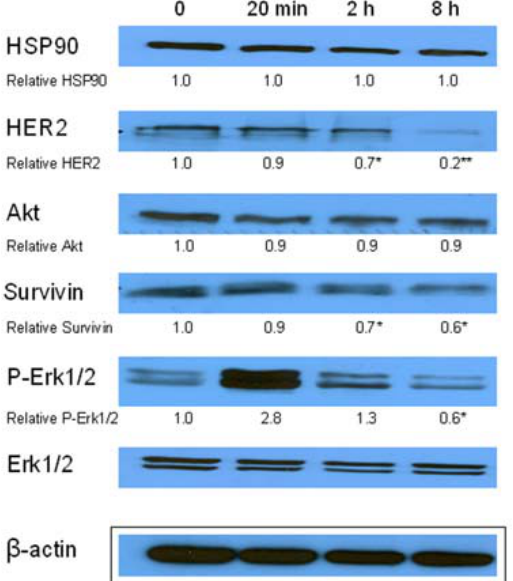
Figure 5. The effect of 17-DMAG treatment on HSP90, HER2, Akt, Survivin and P-Erk1/2 protein levels of SKBR-3 cells in different time after 17-DMAG. Total cell lysates were prepared 0, 20 min, 2 h or 8 h after 17-DMAG (19 nM) treatment. Equal loading was confirmed by detection of beta actin expression. The relative amounts (densitometric levels) of HSP90, HER2, Akt, Survivin and P-Erk1/2 were normalized to beta actin and Erk1/2,